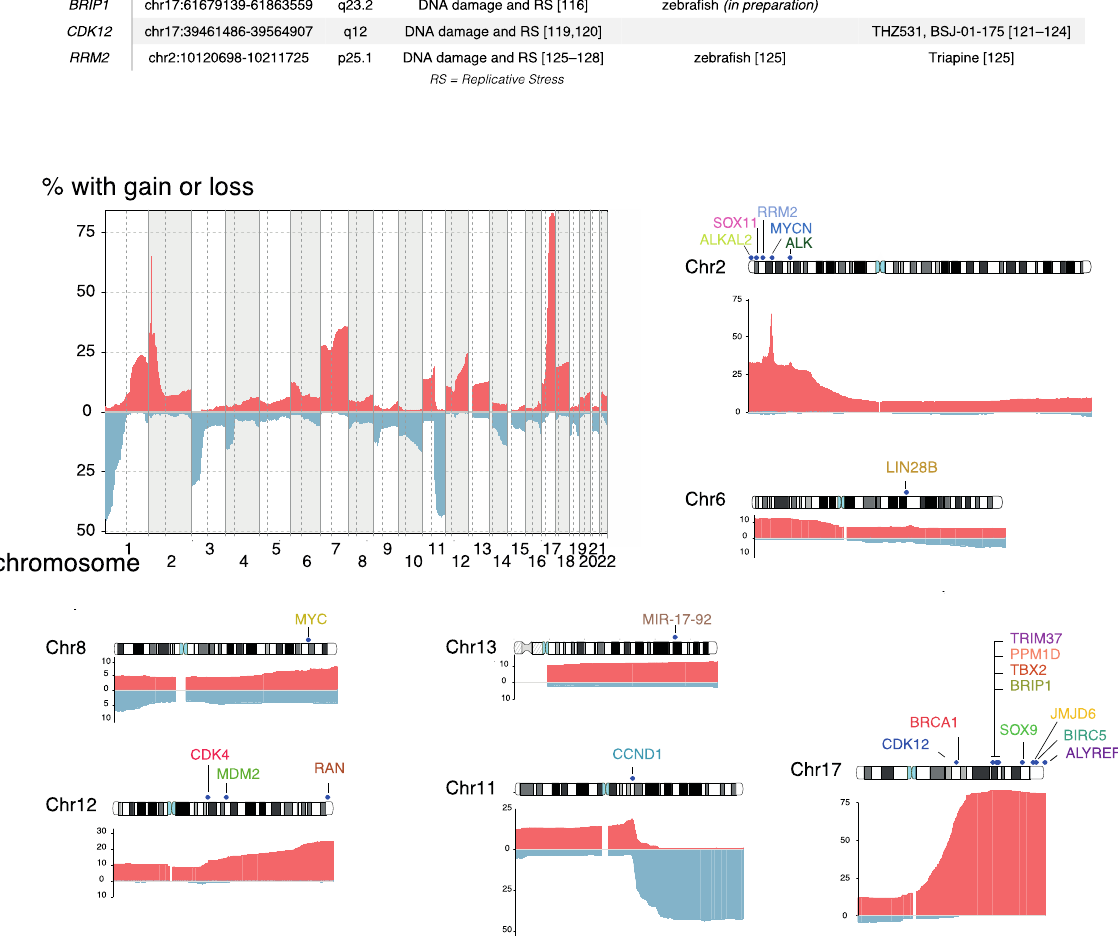
Figure 2. Table describing the copy number affected genes discussed in this review, their chromosomal location and cytoband, their main function with references, in vivo modeling with references, and drugs on target with references. Frequency of copy number gains/amplifications (red) and losses (blue) for chromosomes 1 to 22 in 542 high-risk NB samples with segmental CNAs [38]. Copy number affected genes in NB that were discussed in this review are depicted on their chromosome with the associated copy number frequency (chromosome 2, 6, 8, 11, 12, 13 and 17). Refs. [22,23,40,45–48,50–128] are cited in Figure